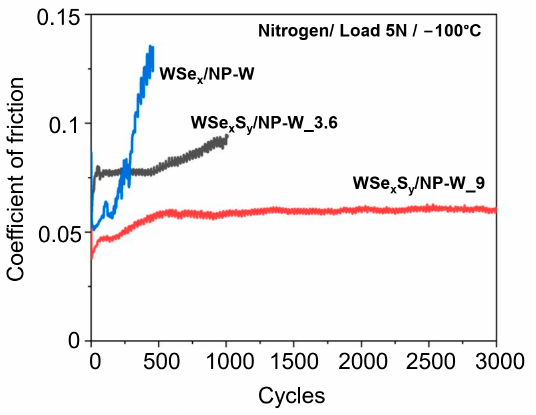
Figure 7. The friction coefficient of WSe x /NP-W, WSe x S y /NP-W_3.6, and WSe x S y /NP-W_9 coatings measured in a N 2 -enriched environment under a load of 5N. The tested samples were cooled to − 100 °C.